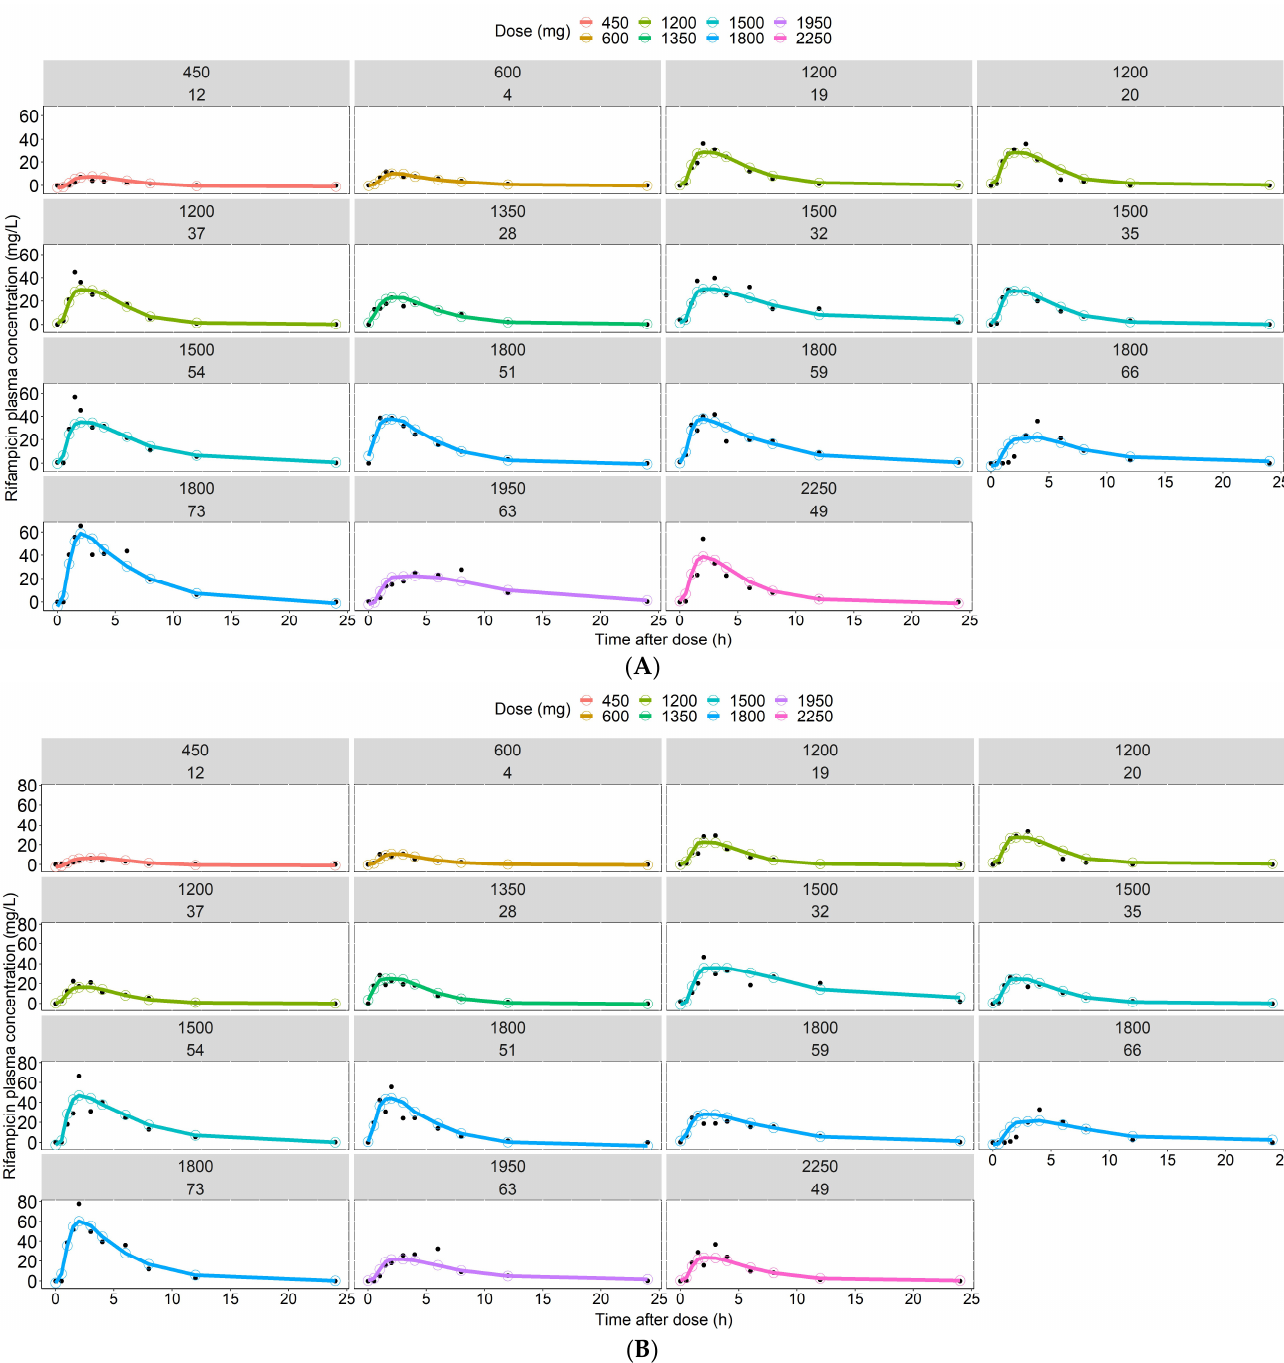
Figure 7. Individual rifampicin plasma concentrations predicted from the XGBoost model (solid line and open circles) compared to the concentrations simulated from the population PK model, consid- ered to be observations in this study (black closed circles) shown for scenario 3 (features and 6 plasma concentrations used for prediction) for 15 randomly selected IDs. Panel ( A ) represents the predictions for each individual in the test dataset at day 7. Panel ( B ) represents the predictions for each individual in the test dataset at day 14. The different colors indicate the different daily rifam- picin doses.